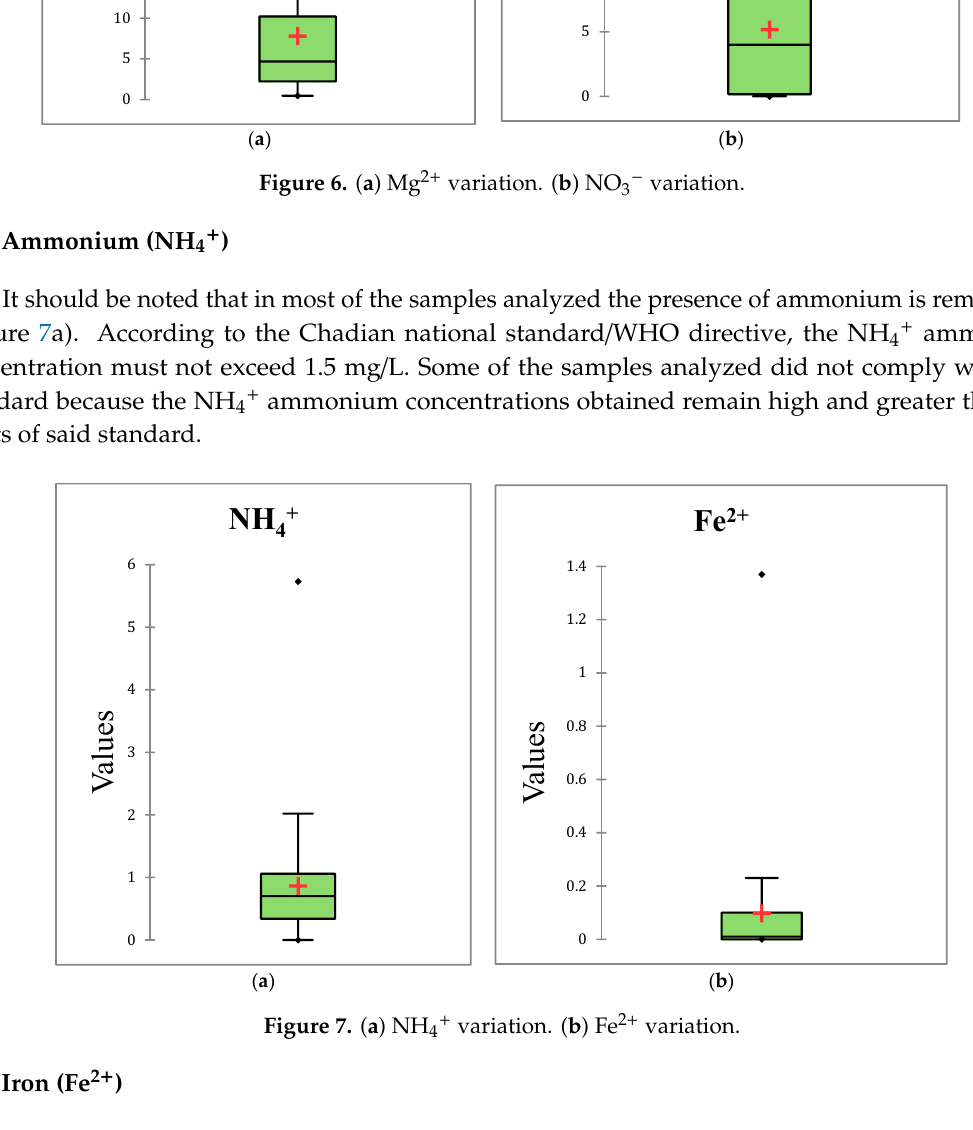
Figure 6. a )Mg 2+ variation. b ) NO 3 − variation. Figure 6. ( a ) Mg 2 + variation. ( b ) NO 3 − variation.